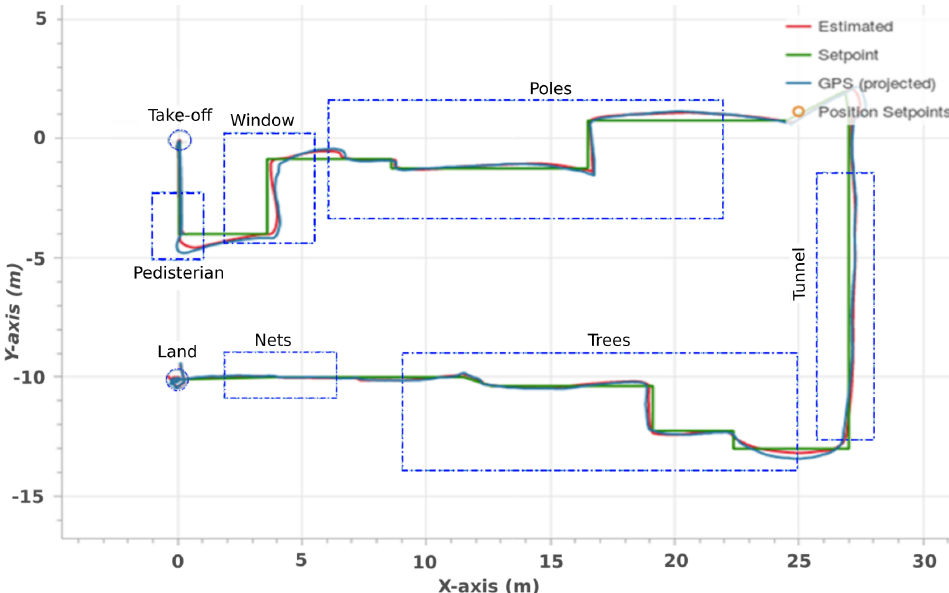
Figure 12. Estimated position and position setpoint comparison in real flight